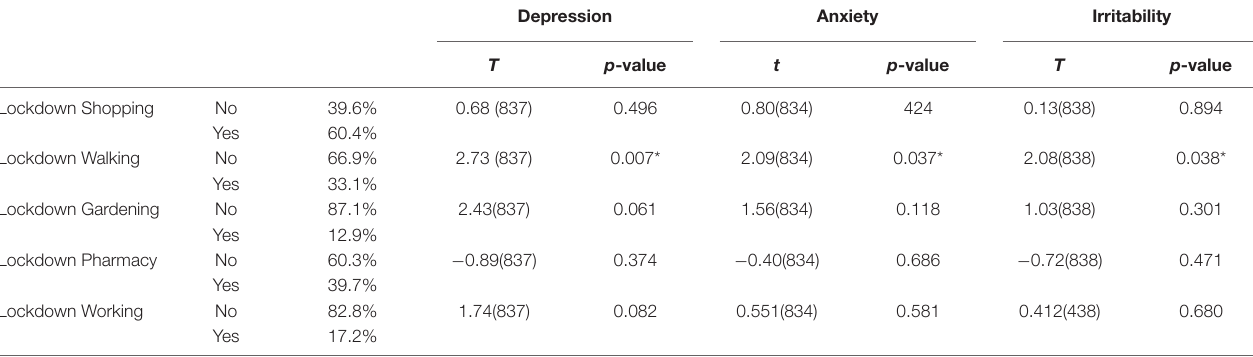
TABLE 10 | Lockdown behaviors and comparisons with psychosocial factors among the elderly. Depression Anxiety Irritability T p -value t p -value T p